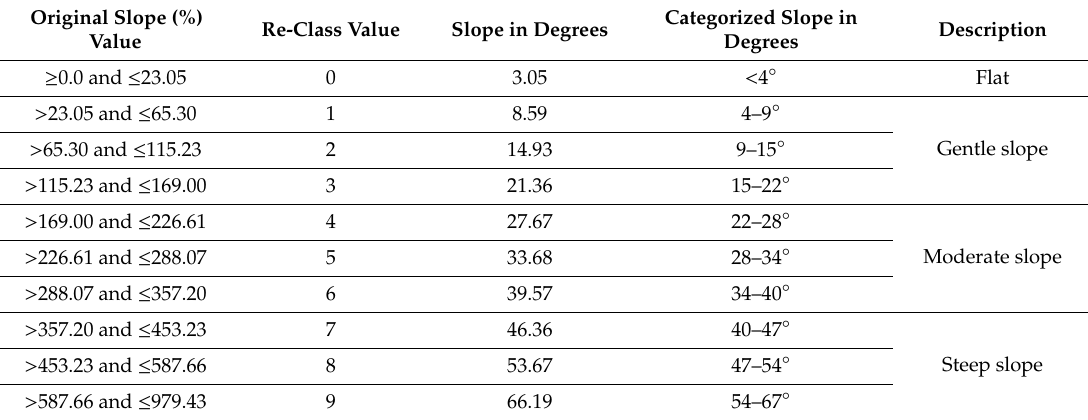
Table 4. Categorization of